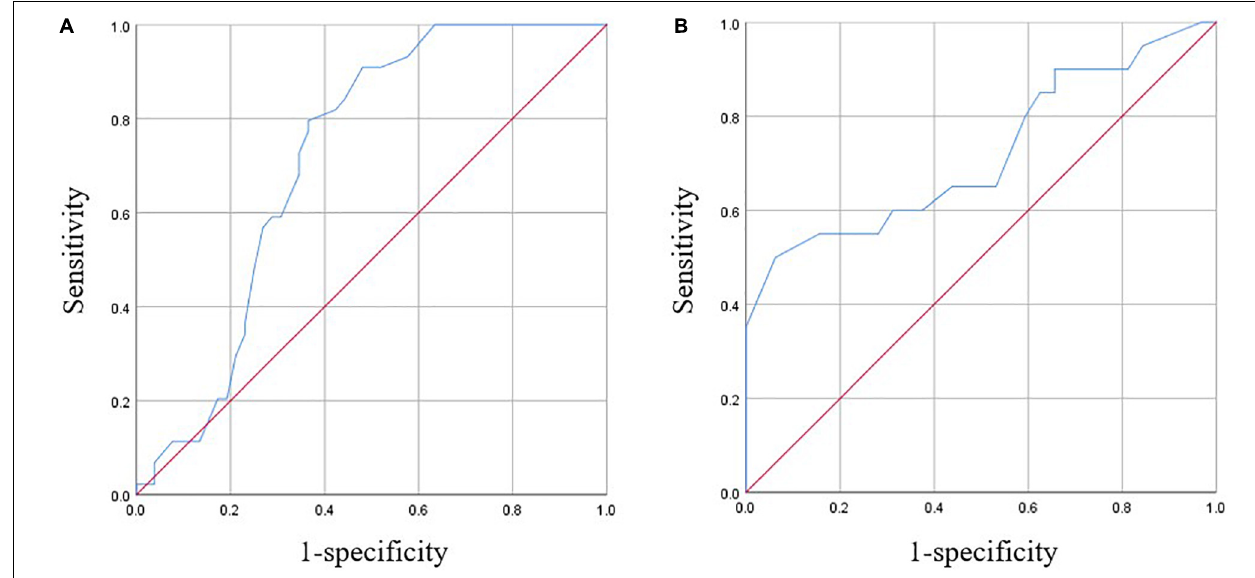
FIGURE 4 | Receiver operating characteristic (ROC) curves of hemoglobin for major complications. (A) For males. (B) For females.